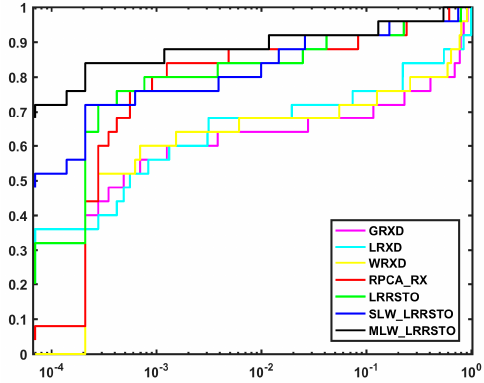
Figure 8. Receiver operating characteristic (ROC) evaluation of the different methods for the AVIRIS_Salinas data. Table 3. Area under the curve (AUC) values for the different detectors with the AVIRIS_Salinas dataset.